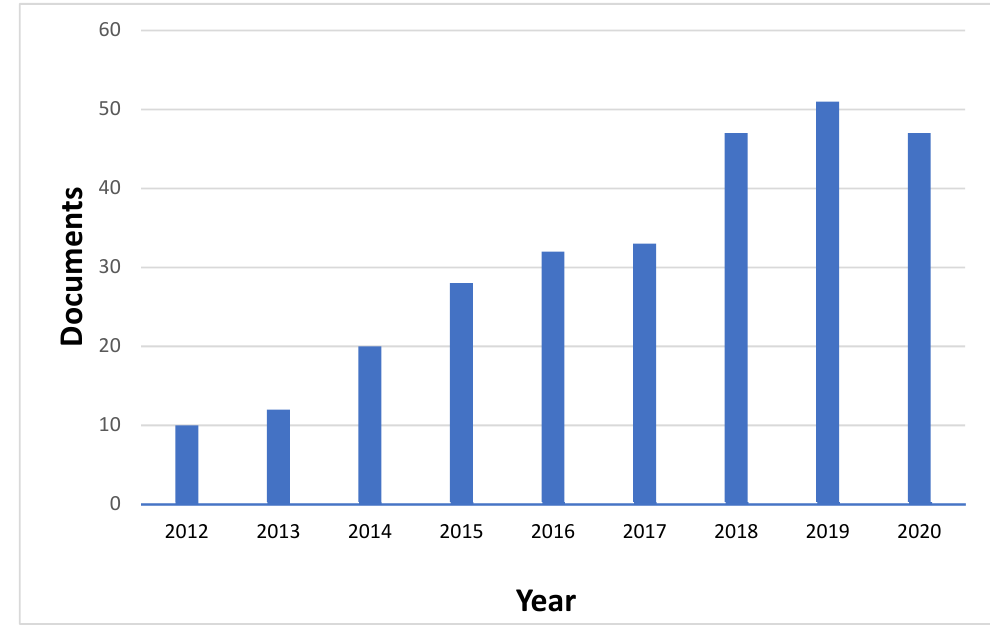
Figure 6. Distribution of annual documents regarding the M-cycle [34].